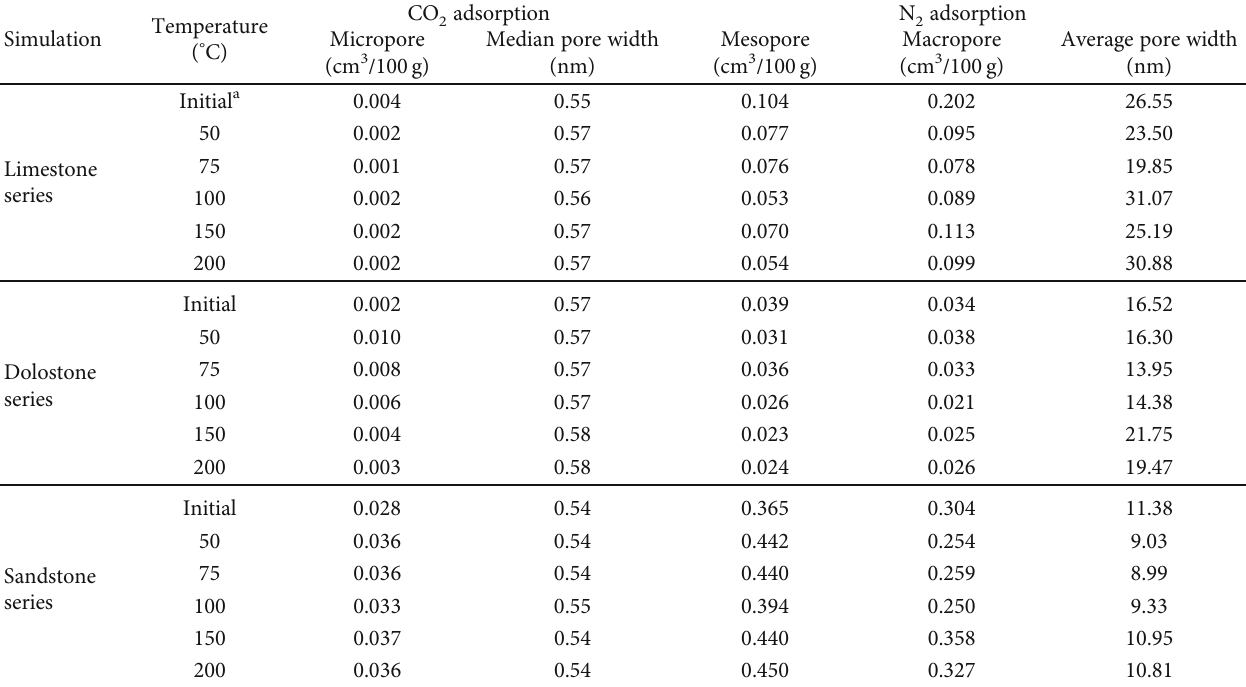
Table 4: Pore characteristics of initial and altered rock